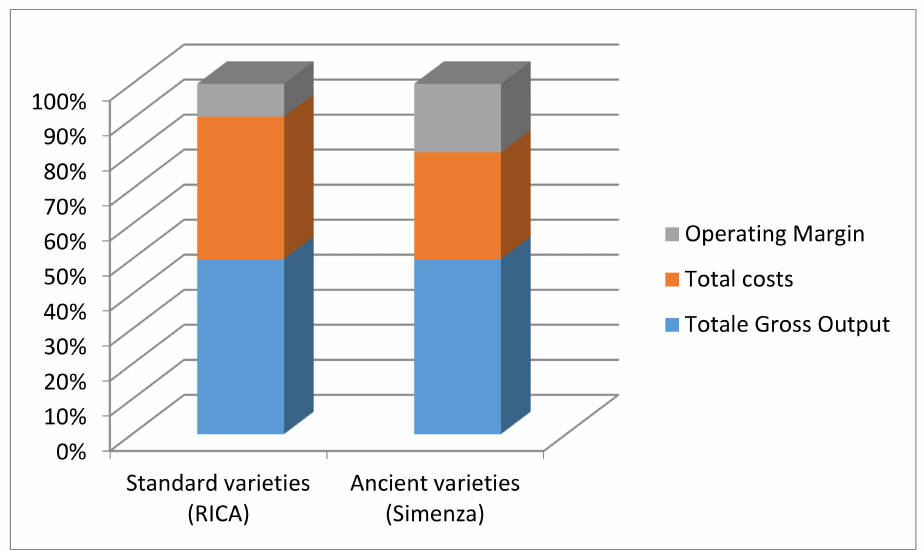
Figure 5. Comparison between economic indicators (average period